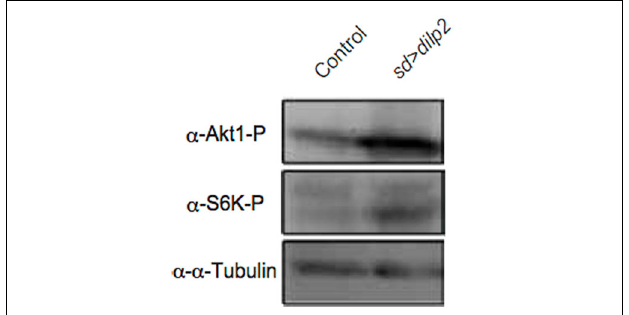
FIGURE 2 | dilp2 -overexpression activates Akt1 and S6 kinase (S6K). The amount of phosphorylated Akt1 and S6K were analyzed by western blots. α -tubulin was used as a loading control.